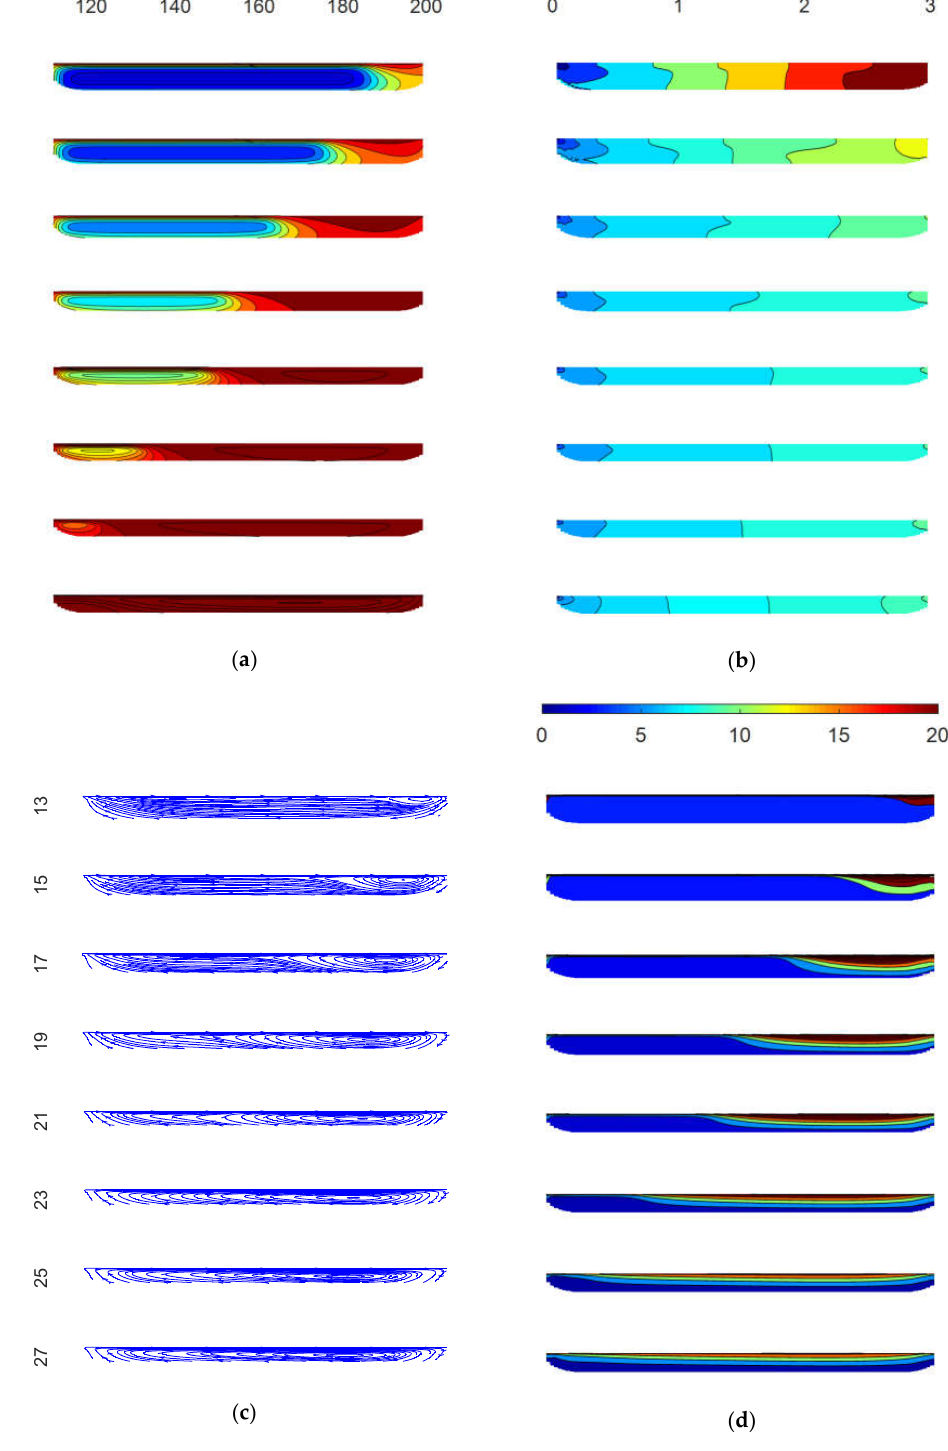
Figure 8. Simulation results for every other turn between 13–27 in the general purpose screw with ( a ) temperature ( C); ( b ) pressure (MPa); ( c ) streamlines; and ( d ) downstream velocity (mm/s).